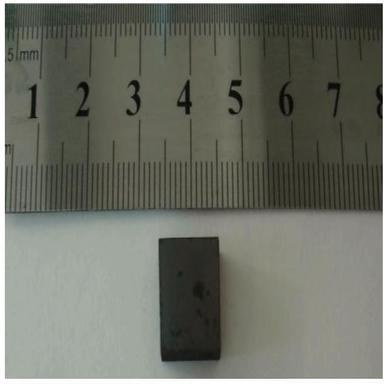
Unsealed sample of pure uranium metal.